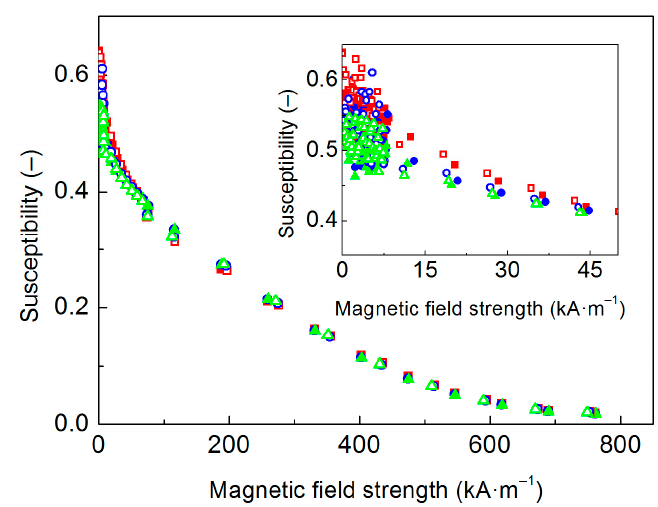
Figure 4. Differential susceptibility curves of the MREs containing ( red squares ) bare CI, ( blue circles ) CI- g -PHEMATMS-1, and ( green triangles ) CI- g -PHEMATMS-2 particles. The closed/open symbols denote data for decreasing/increasing magnetic field, while the inset magnifies the low-field susceptibilities.